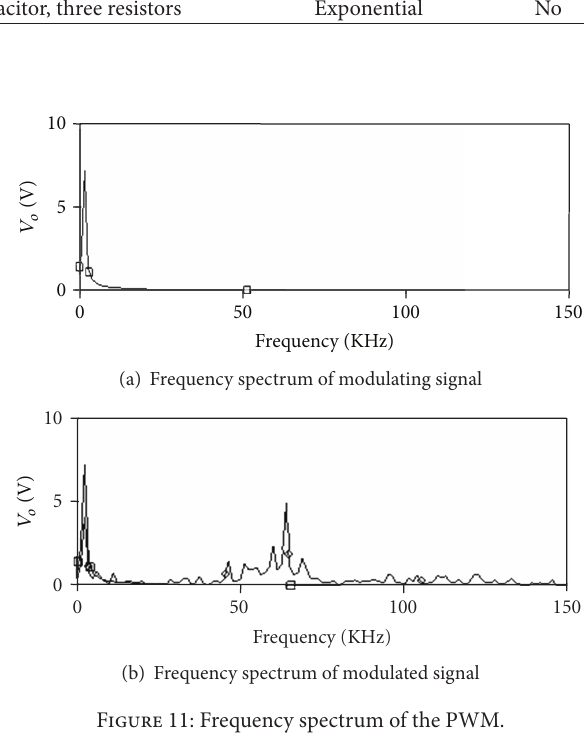
F 11: Frequency spectrum of the